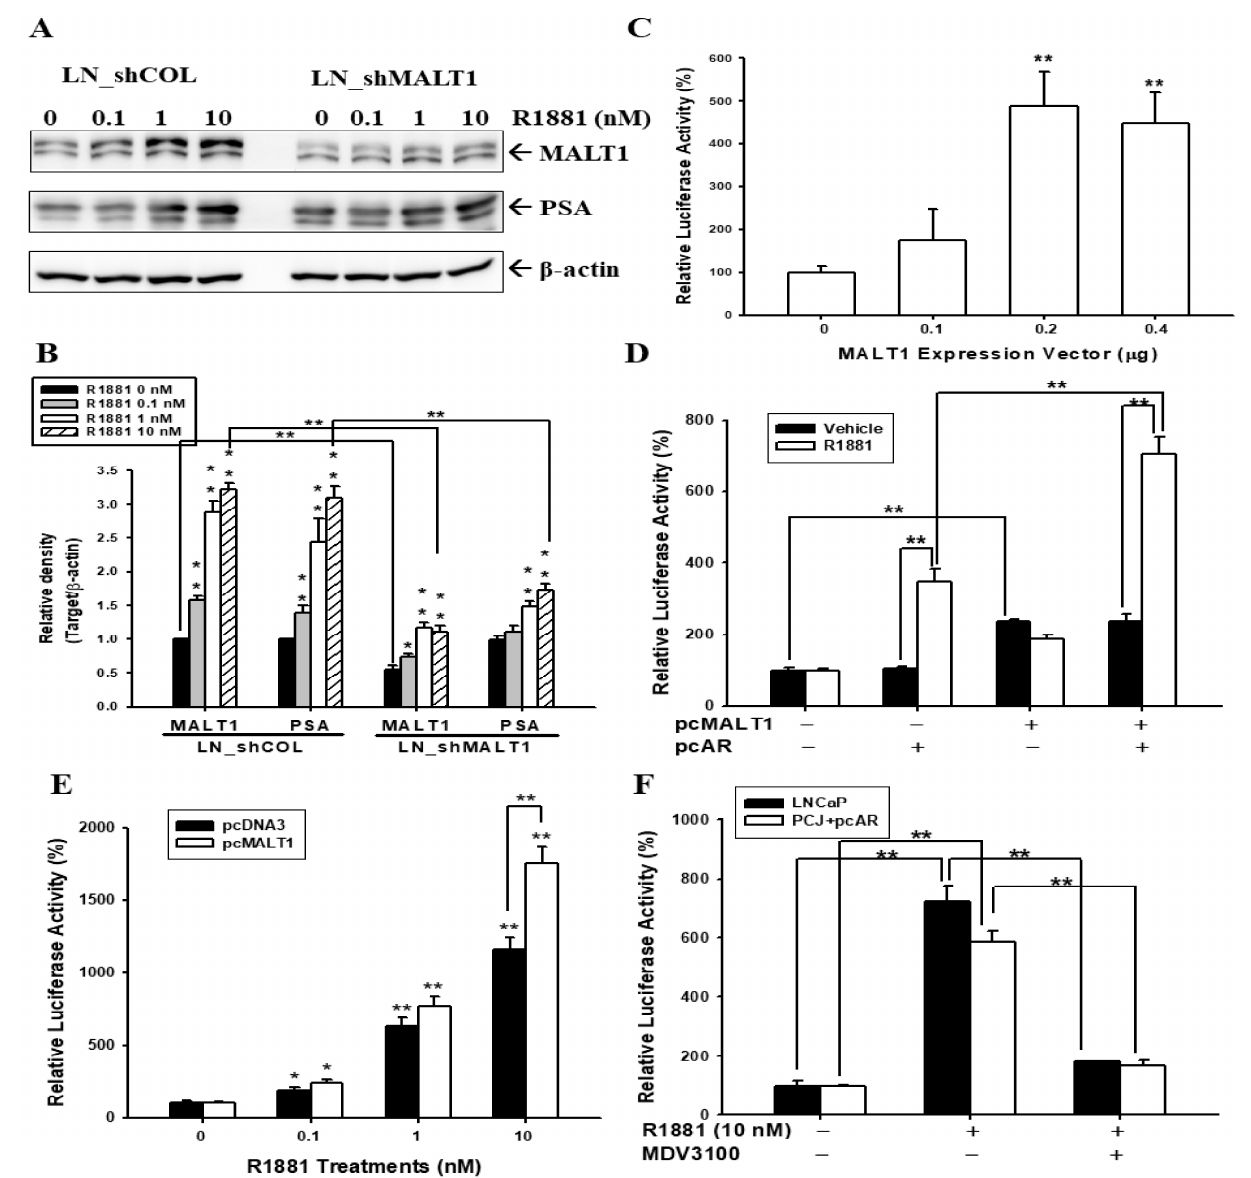
Figure 2. Effects of androgen and MALT1 on PSA expression in androgen-dependent LNCaP prostate cancer cells. The mock-knockdowned LNCaP (LN_shCOL) and MALT1-knockdowned LNCaP (LN_shMALT1) cells were treated with various concentrations of R1881 as indicated for 24 h. The cells were lysed, then MALT1, PSA, and β -actin were determined by ( A ) immunoblot assays and ( B ) quantitative analysis. ( C ) The reporter activity of the PSA reporter vector was cotransfected with various concentrations of MALT1 expression vectors in LNCaP cells. ( D ) The reporter activity of the PSA reporter vector was cotransfected with MALT1 and/or AR expression vectors and treated with/without 10 nM R1881 in PCJ cells. ( E ) The reporter activity of the PSA reporter vector was cotransfected with MALT1 expression vectors (white bars) or control vectors (pcDNA3, black bars), and then treated with various concentrations of R1881 as indicated for 24 h in the LNCaP cells. The data are presented as mean percentages (±SE, n = 6) relative to the control vehicle-treated group. ( F ) The luciferase activity of the PSA reporter vector was treated with/without 10 nM R1881 and 0.1 µM MDV3100 as indicated for 24 h in LNCaP or transient overexpressed AR PCJ cells. * p < 0.05, ** p < 0.01.